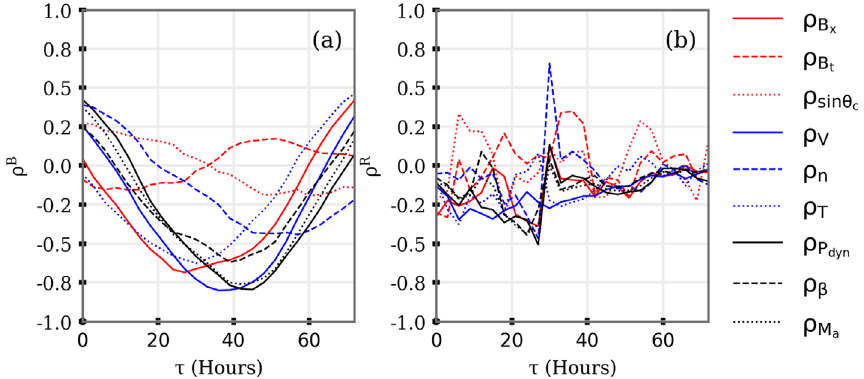
Fig. 2. Cross-correlation functions of different solar-wind parameters with (a) GOES fl ux background ( B ) and (b) ratio ( R ) of hard (0.05 – 0.4 nm) and soft (0.1 – 0.8 nm) X-ray fl